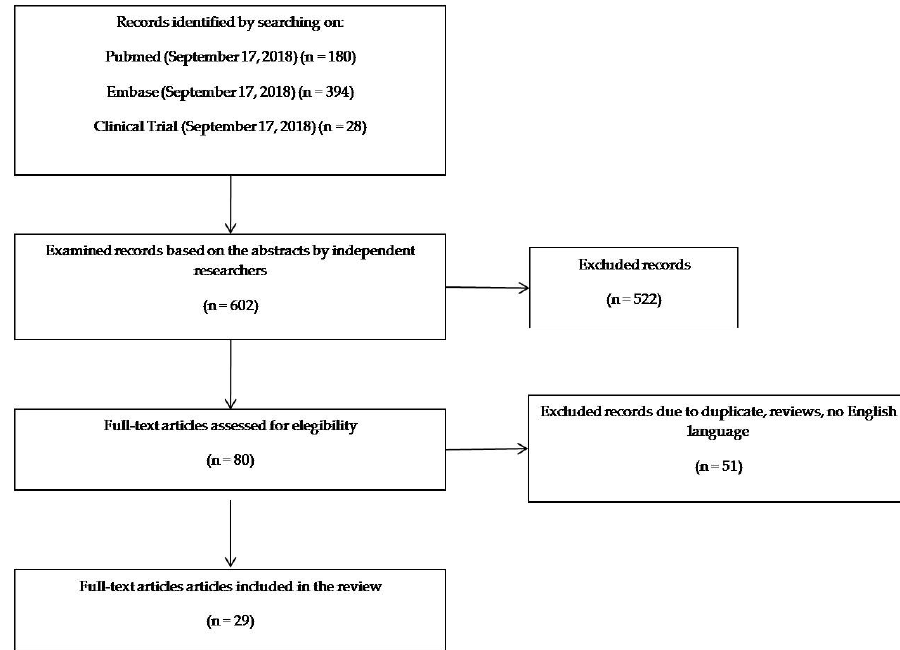
Figure 1. diagram of search strategy and study selection.